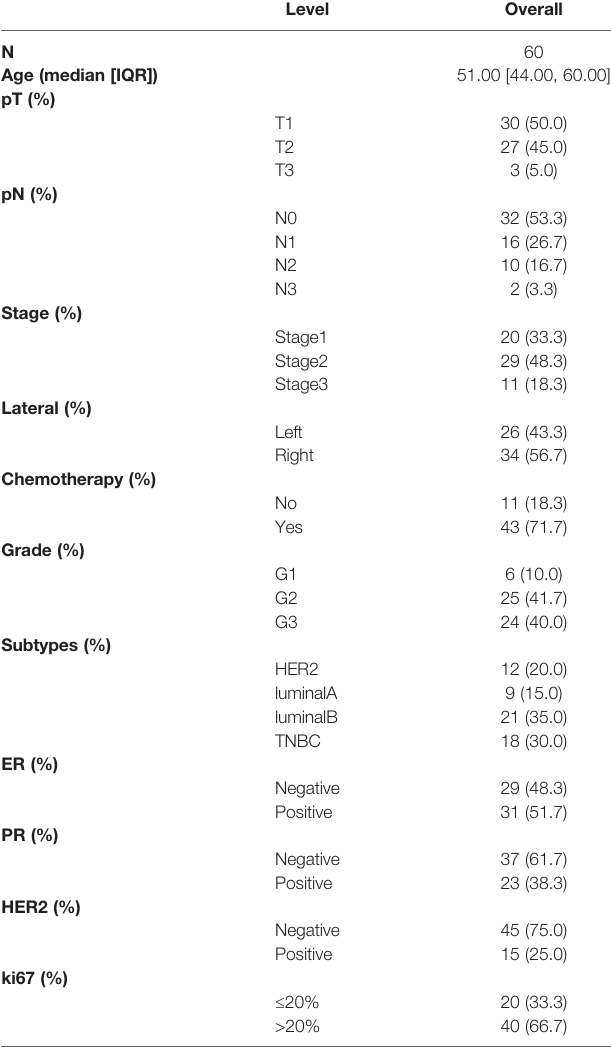
TABLE 1 | Clinical and pathological features of patients in the WMU Breast cohort. Level